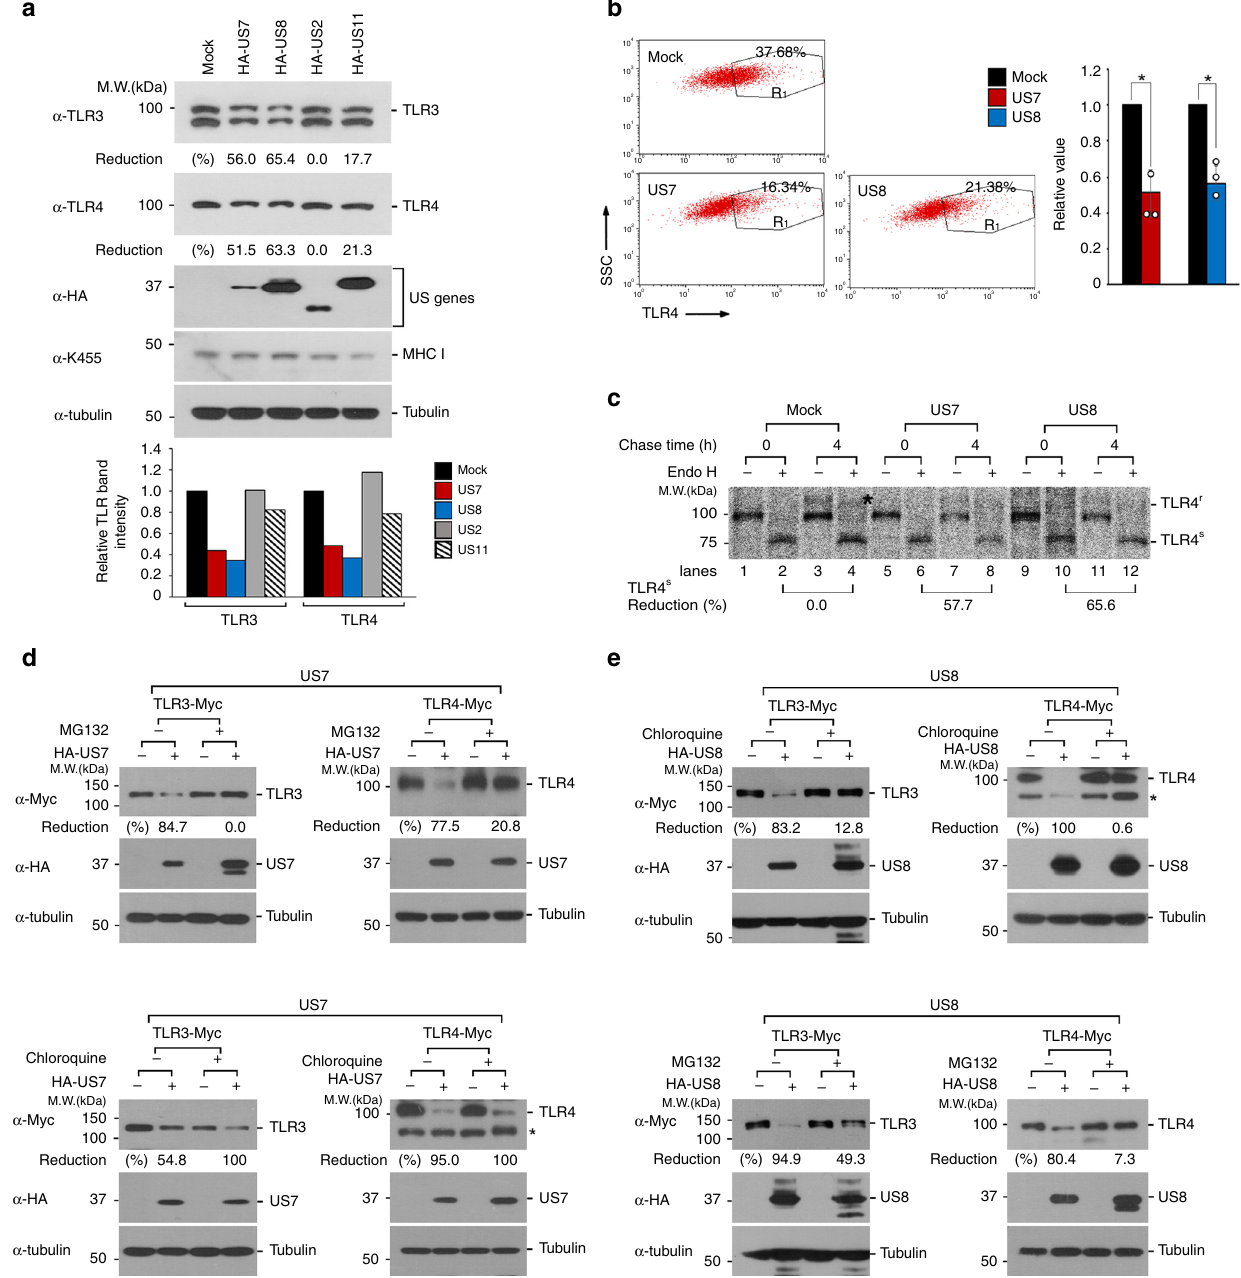
Fig. 2 HCMV US7 and US8 destabilize TLR3 and TLR4. a US7 and US8 degrade TLR3 and TLR4. HeLa cells were transfected with empty vector, HA-US2, HA-US7, HA-US8, or HA-US11 and then the lysates were immunoblotted with anti-TLR3, anti-TLR4, anti-HA, anti-MHC class I molecules (K455), or anti- Tubulin antibody. The intensity of TLRs bands was quanti fi ed as comparing the relative abundance of TLR3 or TLR4 to Tubulin (bottom graphs). b US7 and US8 downregulate the cell-surface expression of TLR4. Endogenous TLR4 surface expression on U937 cells expressing US7 or US8 was assessed by FACS analysis. Right graph, validation of TLR4 cell surface expression levels in US7- or US8-expressing cells by FACS. * P < 0.001 (Student ’ s t -test). c HeLa cells stably expressing TLR4-Myc were transfected with HA-US7 or HA-US8. Cells were labeled with [ 35 S] methionine/cysteine for 1 h and chased for 4 h. After endo-H treatment, lysates were immunoprecipitated with anti-Myc antibody. Asterisk denotes an endo-H resistant form of TLR4. d , e US7 and US8 destabilize TLR3 and TLR4 by a proteasome-dependent and/or lysosome-dependent pathway. HeLa cells expressing TLR3-Myc or TLR4-Myc were transfected with empty vector, HA-US7 d , or HA-US8 e and then treated with either 20 μ M MG132 or 100 μ M chloroquine for 4 h. Lysates were immunoblotted with the indicated antibodies. Asterisk indicates a non-speci fi c bands. Data are representative of at least three independent experiments and are presented as the mean ± s.d. in b . Source data are provided as a Source Data fi